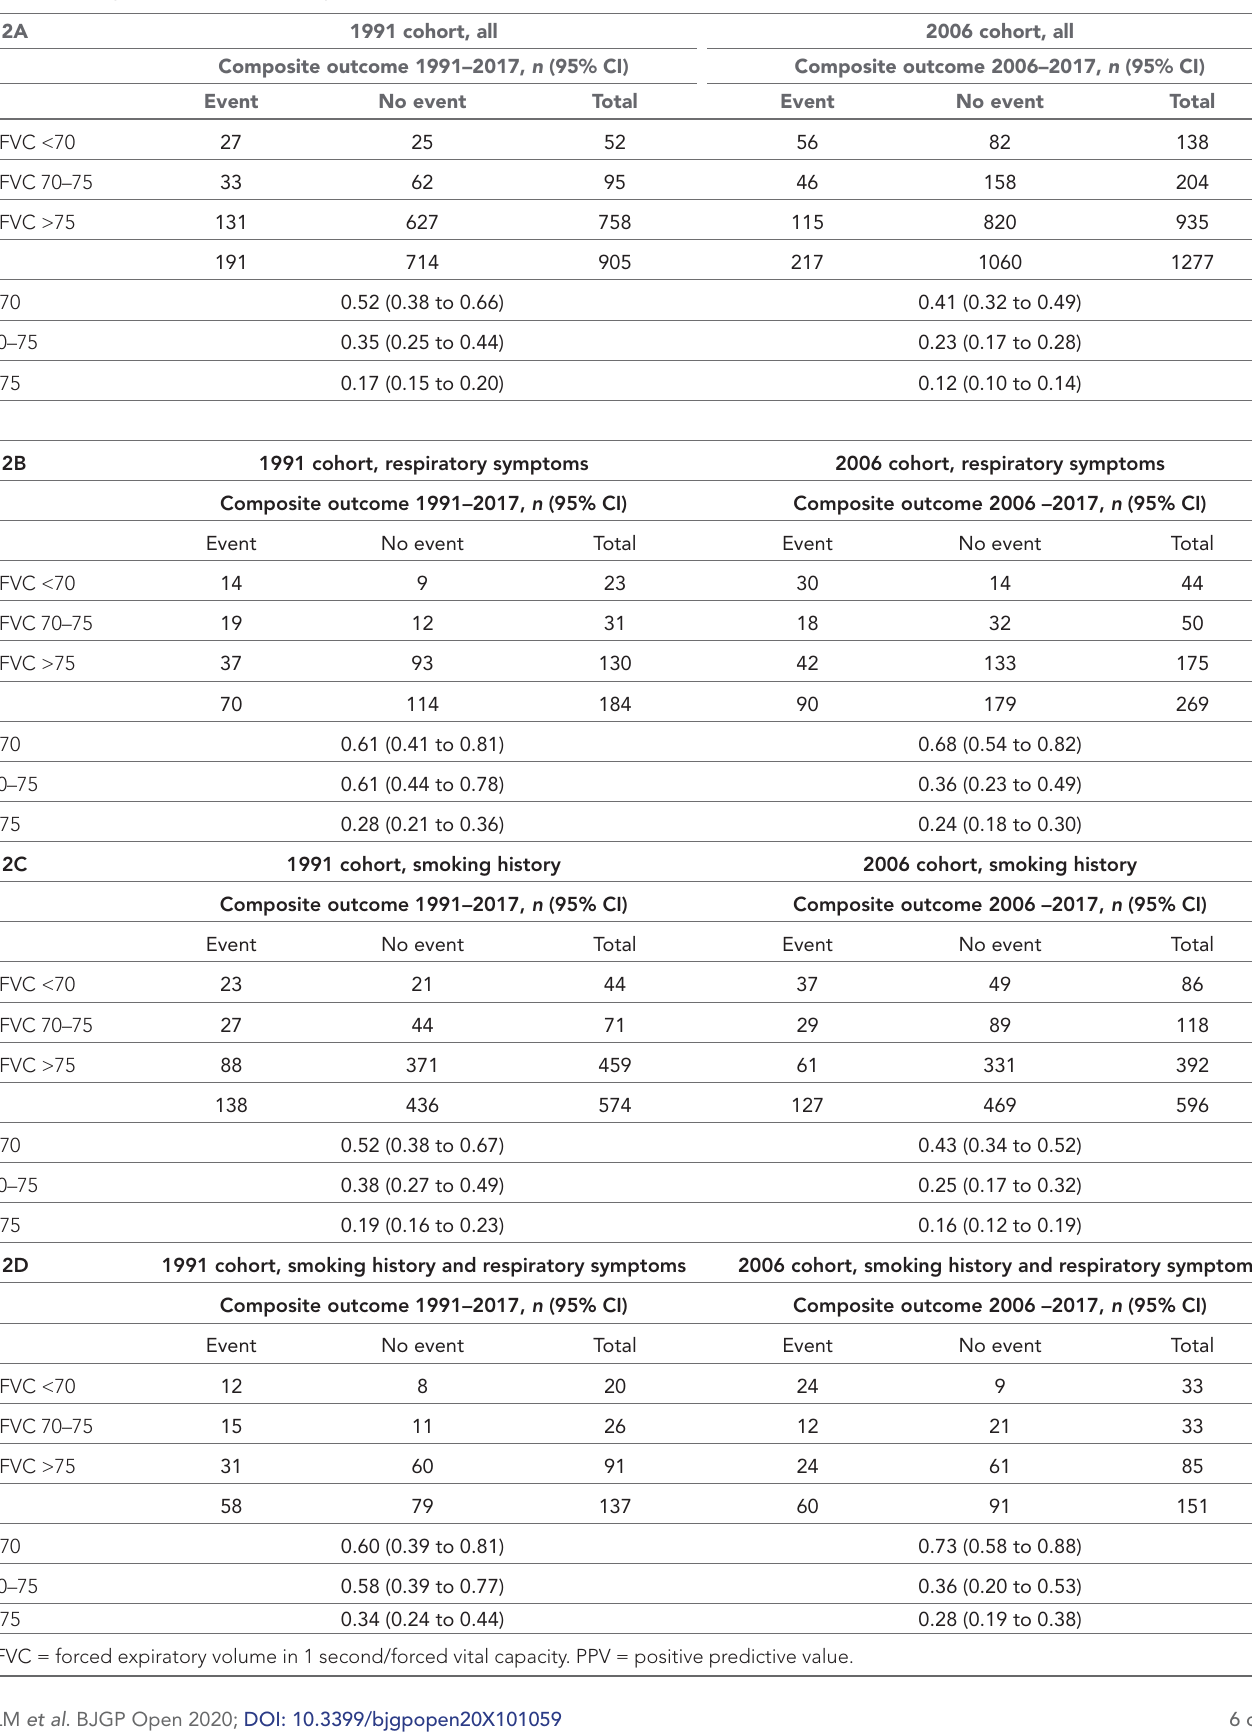
Table 2 Positive predictive value of a positive test calculated on the 1991 cohort and 2006 cohort Table 2A 1991 cohort, all